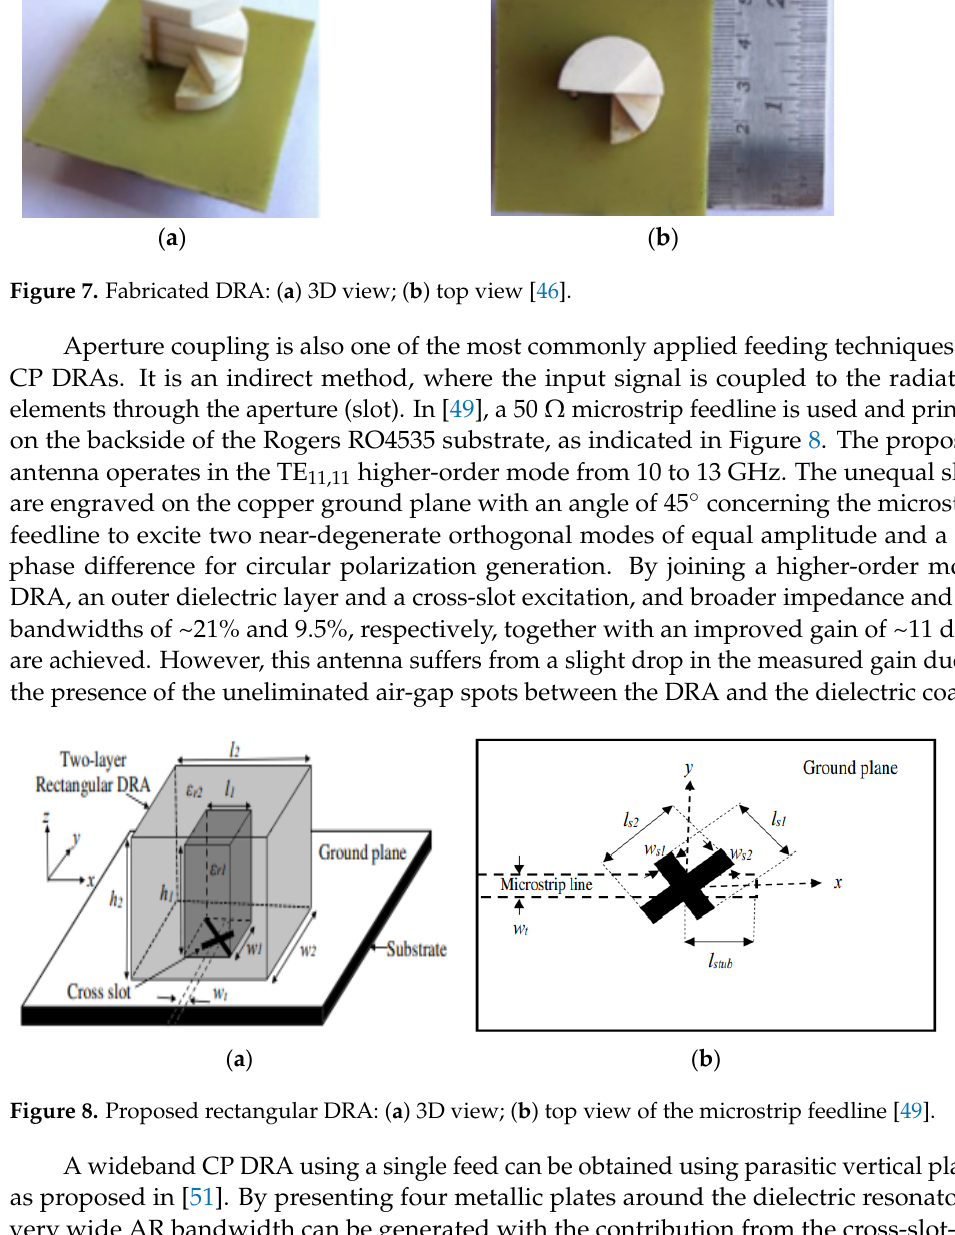
( b ) Figure 9. Proposed cross-slot-fed CP DRA: ( a ) perspective view; ( b ) top view [51]. In [52], a dual-band dual-CP DRA is proposed for unmanned aerial vehicle (UAV) applications. It consists of a metal strip with a rotated angle, a stacked rectangular dielec- tric resonator, and a substrate integrated waveguide cavity with a slot for feeding, as shown in Figure 10. The shared-aperture merged-structure design of DRA and a slot-di- pole antenna are applied to realize circular polarization features. The CP waves are con- trolled by a phase compensation method with tuning processes. It is easier to obtain im- pedance matching by using this feeding technique than a contacting feed. However, the manufacturing process of stacked DRAs is complicated and needs to be carefully opti- mized in order to avoid any errors. A summary of some previous works on various single- feed circularly polarized DRAs are presented in Table 2. It can be concluded that a single feed has a simple geometry because no hybrid coupler is required to generate a 90° phase shift between the two orthogonal modes. CP waves can be realized by modifying the structure of the dielectric resonator to excite two orthogonal modes and the required phase shift. In addition, the dielectric permittivity ε r of the dielectric resonator and its shape will affect the performance of an antenna. Thus, by choosing a dielectric resonator with a high dielectric permittivity, the size of the DRA will be reduced. Moreover, each